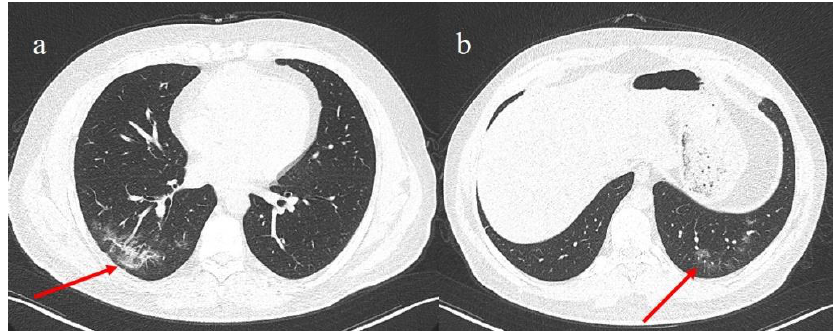
Figure 2. On the left panel ( a ), reduction of the consolidation the right inferior lobe (red arrow) after therapy; on the right panel ( b ), the reduction of areas previously observed as small zones of consolidations with some ground glass (GGO) area (red arrow) in the absorptive phase after therapy.